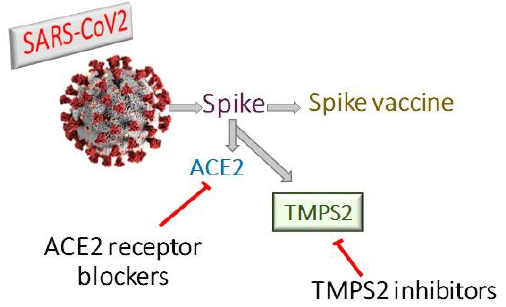
Figure 1. Therapeutic approaches for treatment of covid-19 either by ACE2 receptor blockers, TMPS2 inhibitors or spike vaccine.